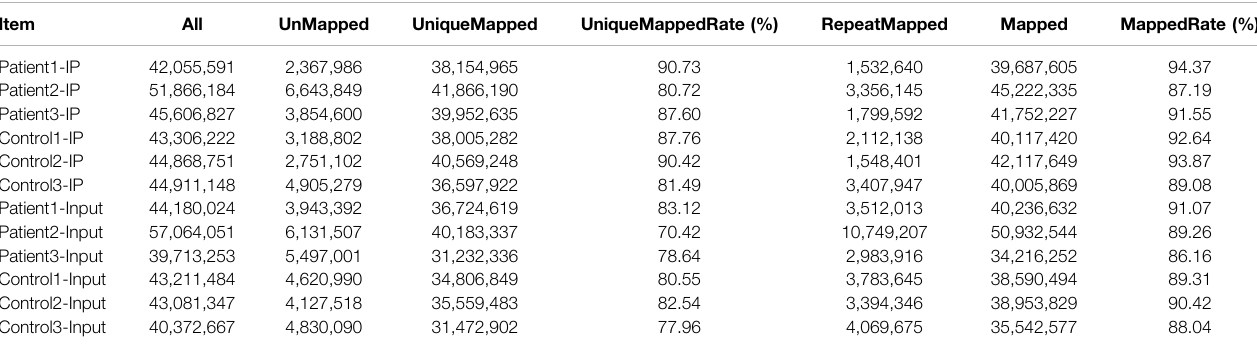
TABLE 3 | Summary of reads mapped to the GRCh38/hg38 reference genome.